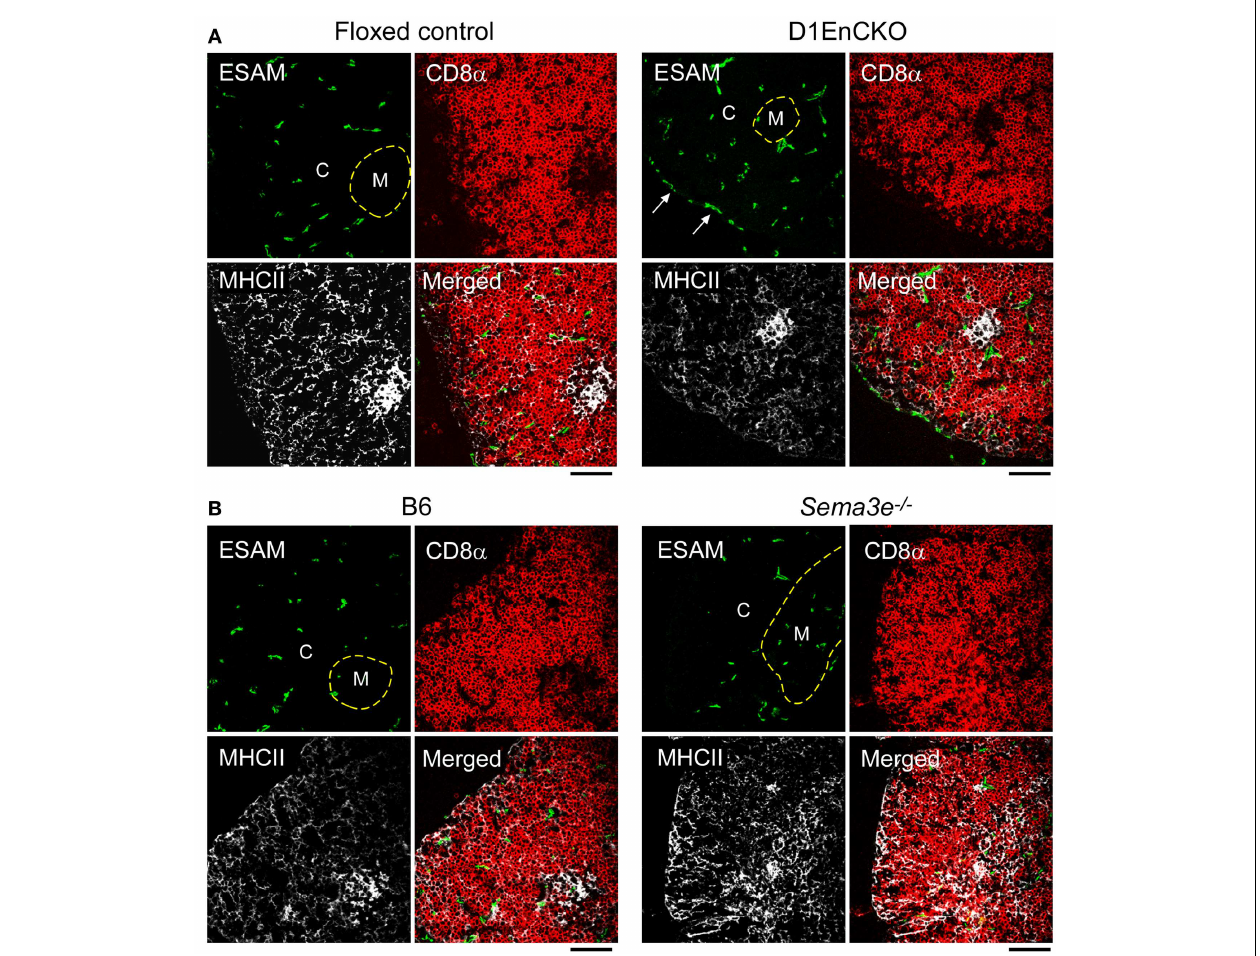
follows the corticomedullary junction.The result is representative of one of three independent experiments.The black bar below each merged image represents 100 µ m and is applicable to every panel in each block. C, cortex; M,